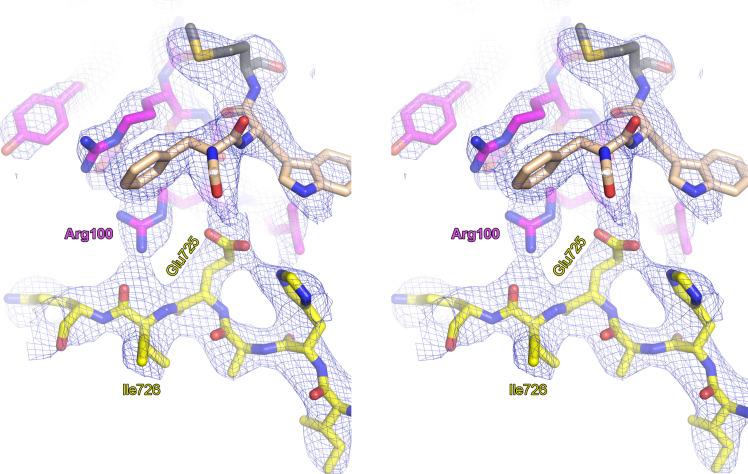
Electron density at the Fab P-4G2−Puumala virus (PUUV) Gc interface.Stereo-view of the interaction between PUUV Gc and CDRH3 of Fab P-4G2, with the simulated annealing composite omit electron density map shown contoured at 1σ. The structure is shown in stick representation, with nitrogen atoms colored blue, oxygen atoms red, and carbon atoms yellow for Gc, salmon for Fab P-4G2 CDRH2, and magenta for Fab P-4G2 CDRH3, respectively. Arginine 100 of CDRH3 and residues Ile726 and Glu725 of Gc, which are predicted by the PDBePISA server to form hydrogen bonds and a salt bridge with Arg100, are labeled.